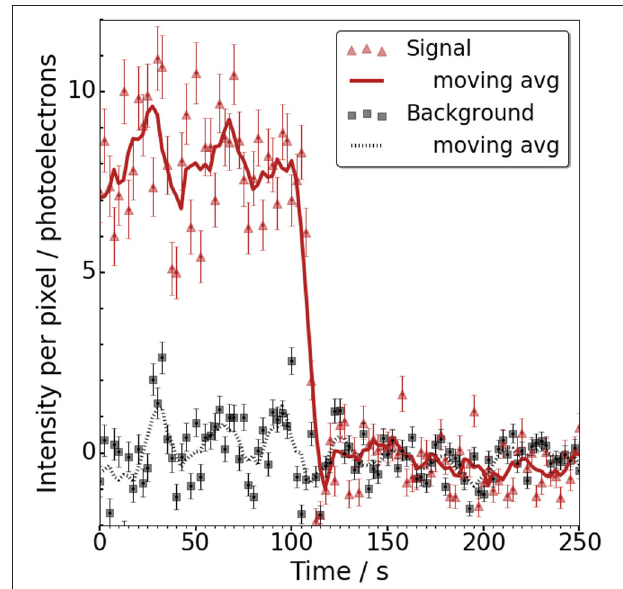
FIGURE 15 | Fluorescence trajectory for one candidate in a barium-spiked sample. “Signal” shows the average activity in 5 maximum. “Background” shows the average in the 56 surrounding. The single step photo-bleach is characteristic of single molecule fluorescence. Figure from McDonald et al.